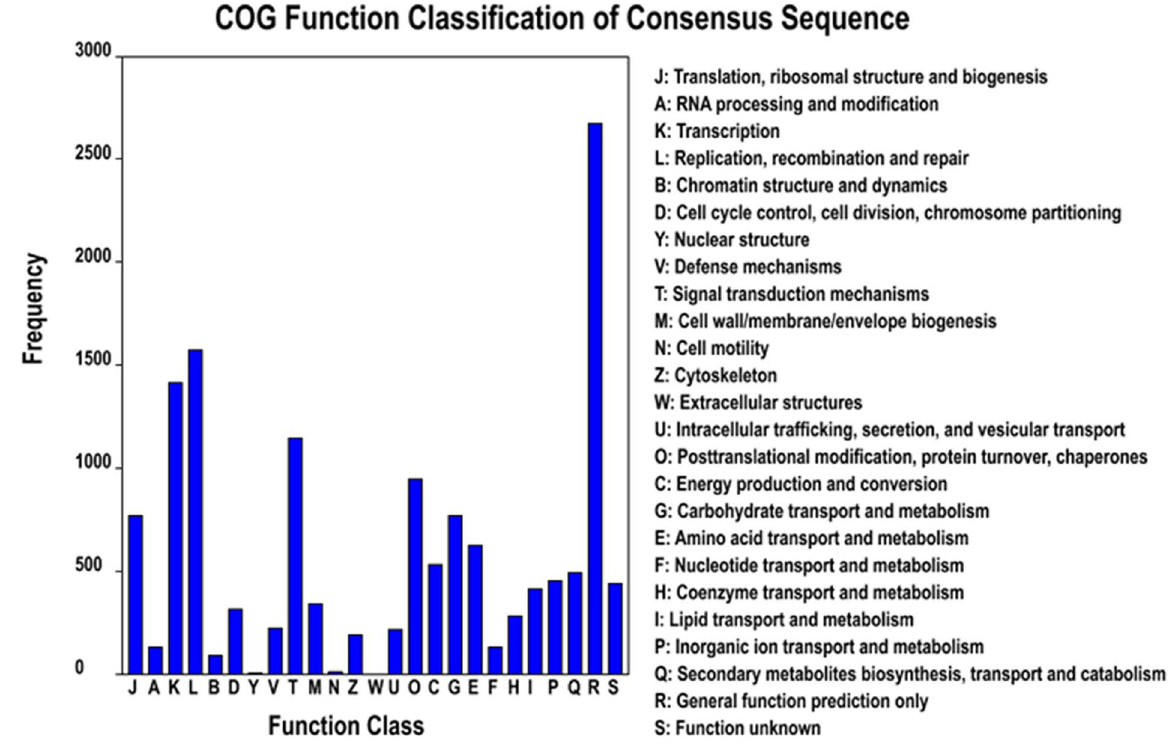
Figure 3. COG annotation.